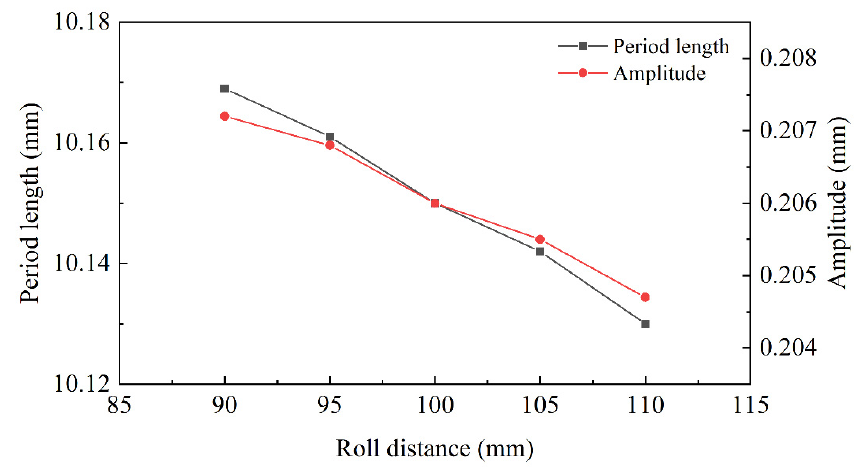
Figure 12. The morphology curve with different roll distances.